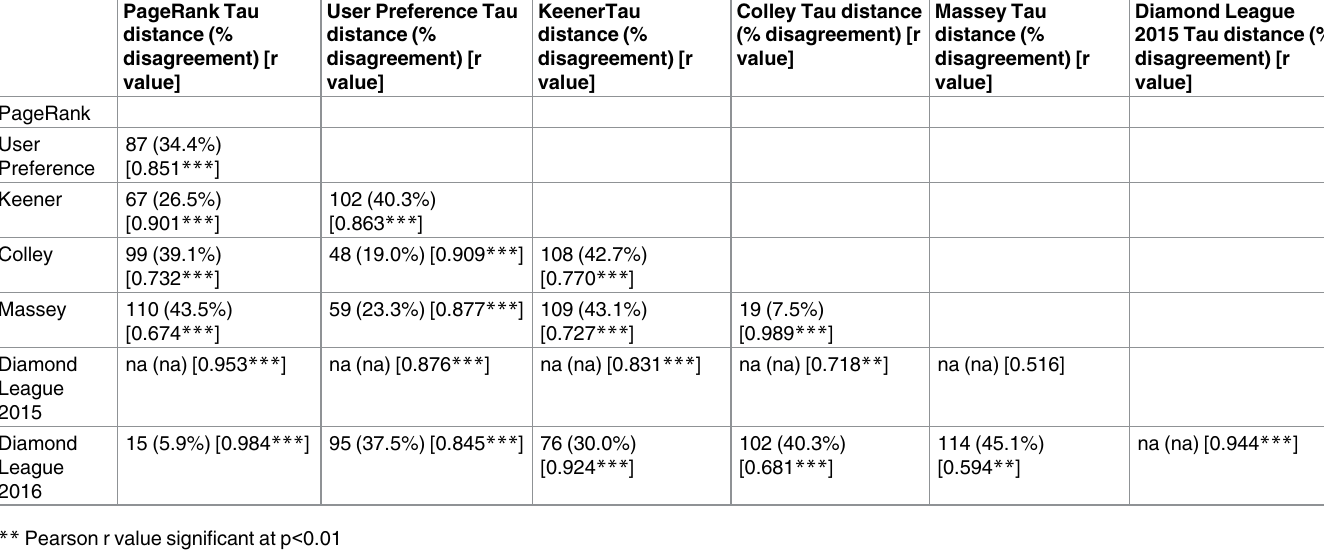
are presented in Table 5. From these it can be seen that the tau distance between the PR stand- ings and ‘2016’ points system standings was 15, indicating that only 5.9% of pairs differed in their order between the two lists. The equivalent tau distances for the Keener and UP standings were 76 (30.0% pair order disagreement) and 95 (37.5% pair order disagreement) respectively, Table 5. Kendall’s tau distance and percentagedisagreement in pair order, together with Pearsoncorrelation r-values, between the top 23 athletes in each of the respective standings. PageRank Tau distance